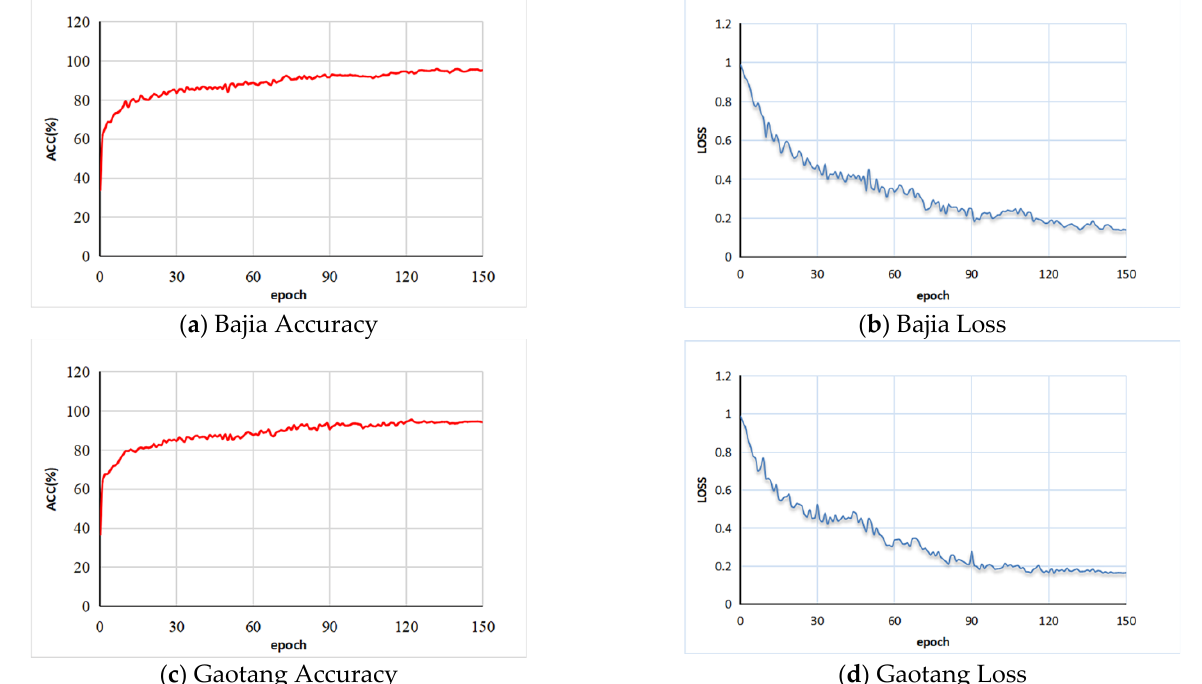
Figure 10. Training accuracy values and loss function curves.